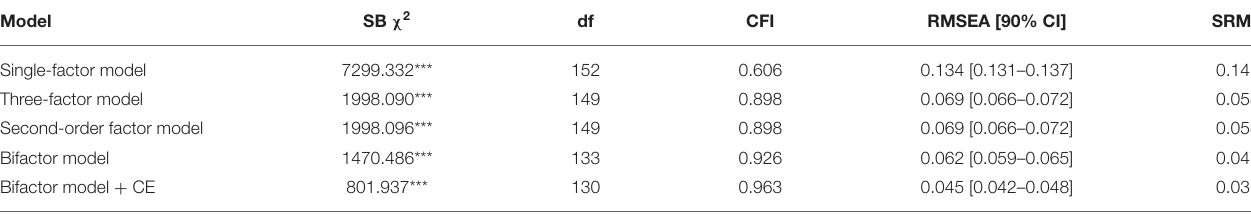
TABLE 2 | Summary of fit indices for structural models of SWB for the total sample. Model